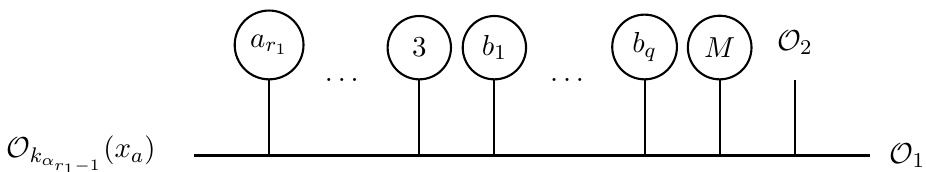
Figure 16 . The comb structure which can be used to construct the cross ratio v 1 j following our